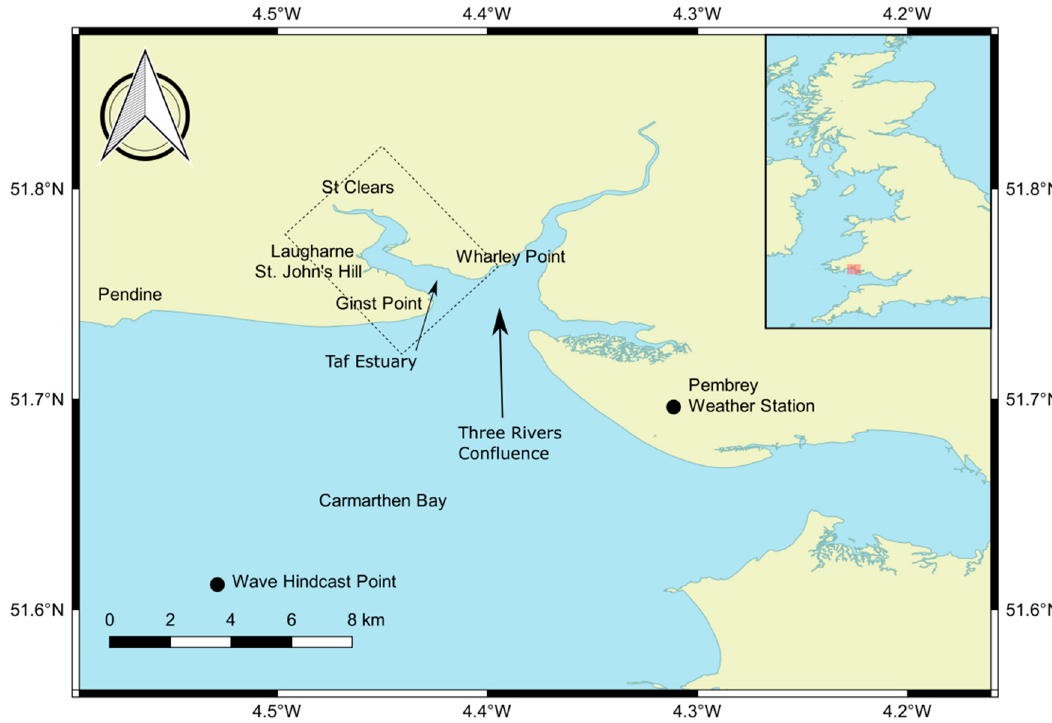
Figure 1. Taf Estuary and its location in Carmarthen Bay, south-west Wales, United Kingdom.